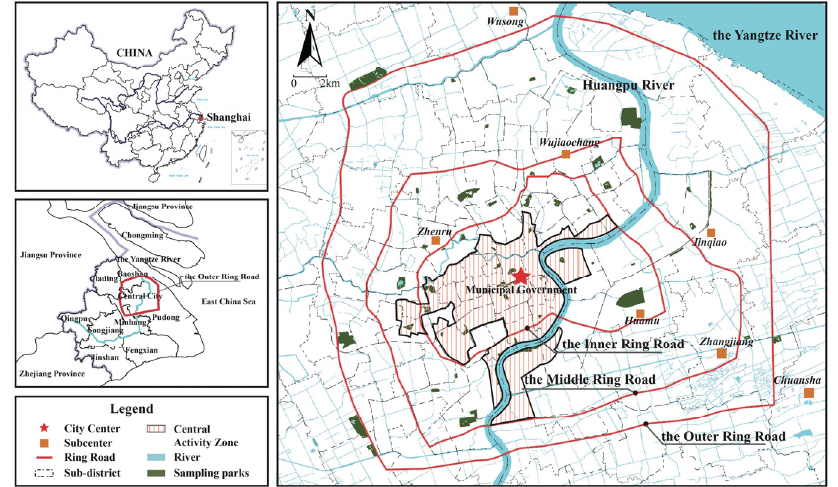
Figure 2. Study area and sampling parks .